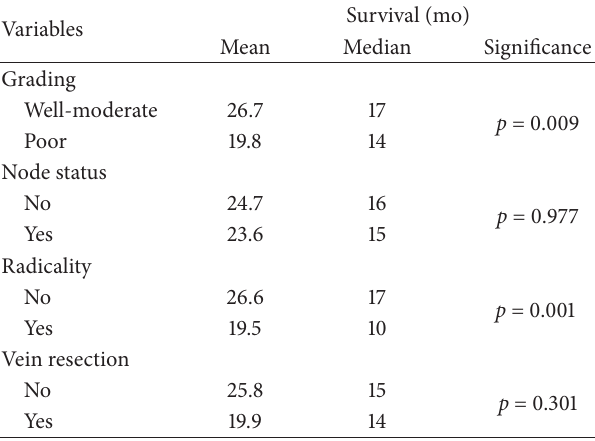
Table 3: Univariate analysis of factors influencing overall survival.